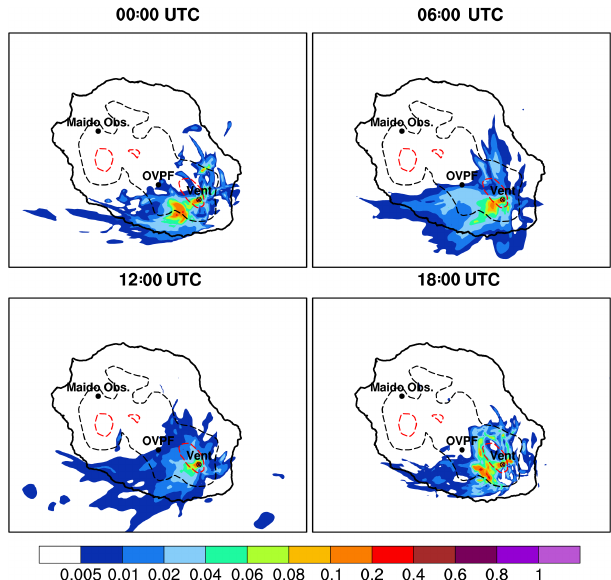
Figure 4. Same as Fig. 3 but for a simulation between 24 August at 00:00UTC and 31 October at